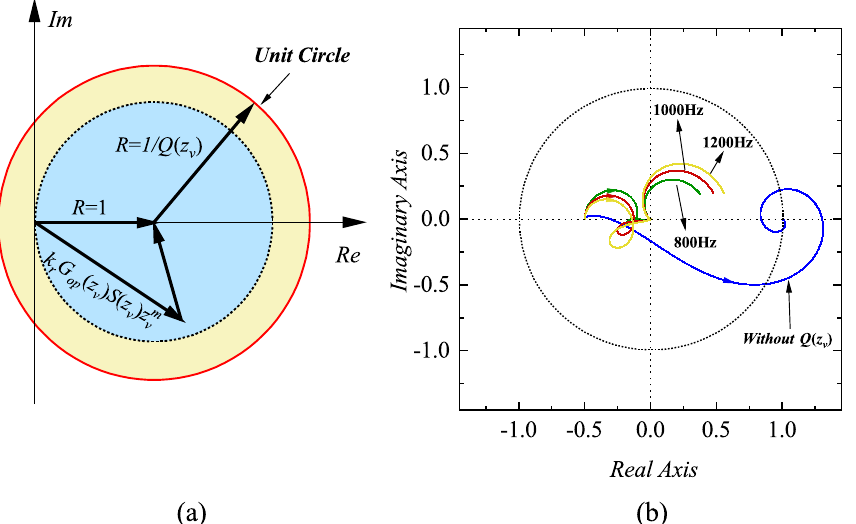
Figure 5. The graphical expression of system stability criteria. ( a ) vector description. ( b ) Nyquist